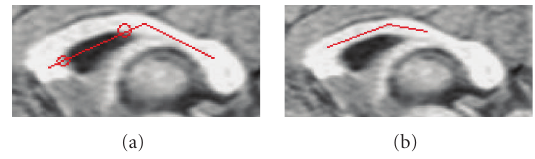
Figure 8: (a) The portion between two circles is outside. (b) The seed not covering the